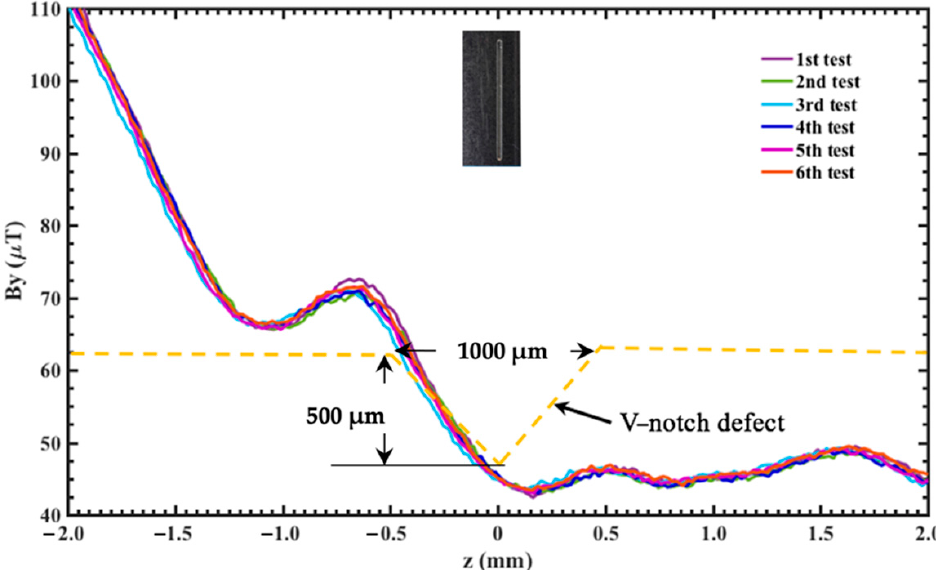
the normal MMM signals had values close to 113.80 ± 0.28 µ T. After the first edge of this defect, these signals decreased to 87.40 µ T ± 0.40 µ T at the second edge of the notch. The width (1500 µ m) of the second notch affected the magnetic signal shift along a distance close to 1.5 mm.